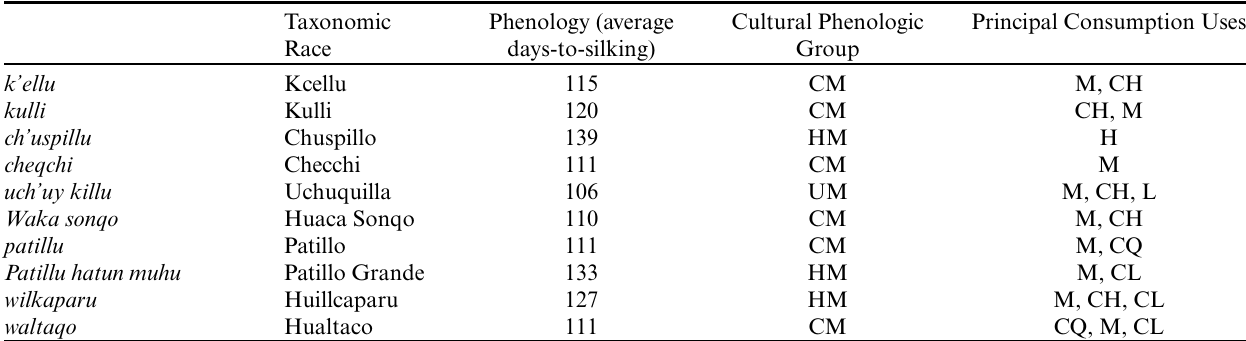
Table 4 . The phenologic variation of maturation period and the principal consumption uses of maize